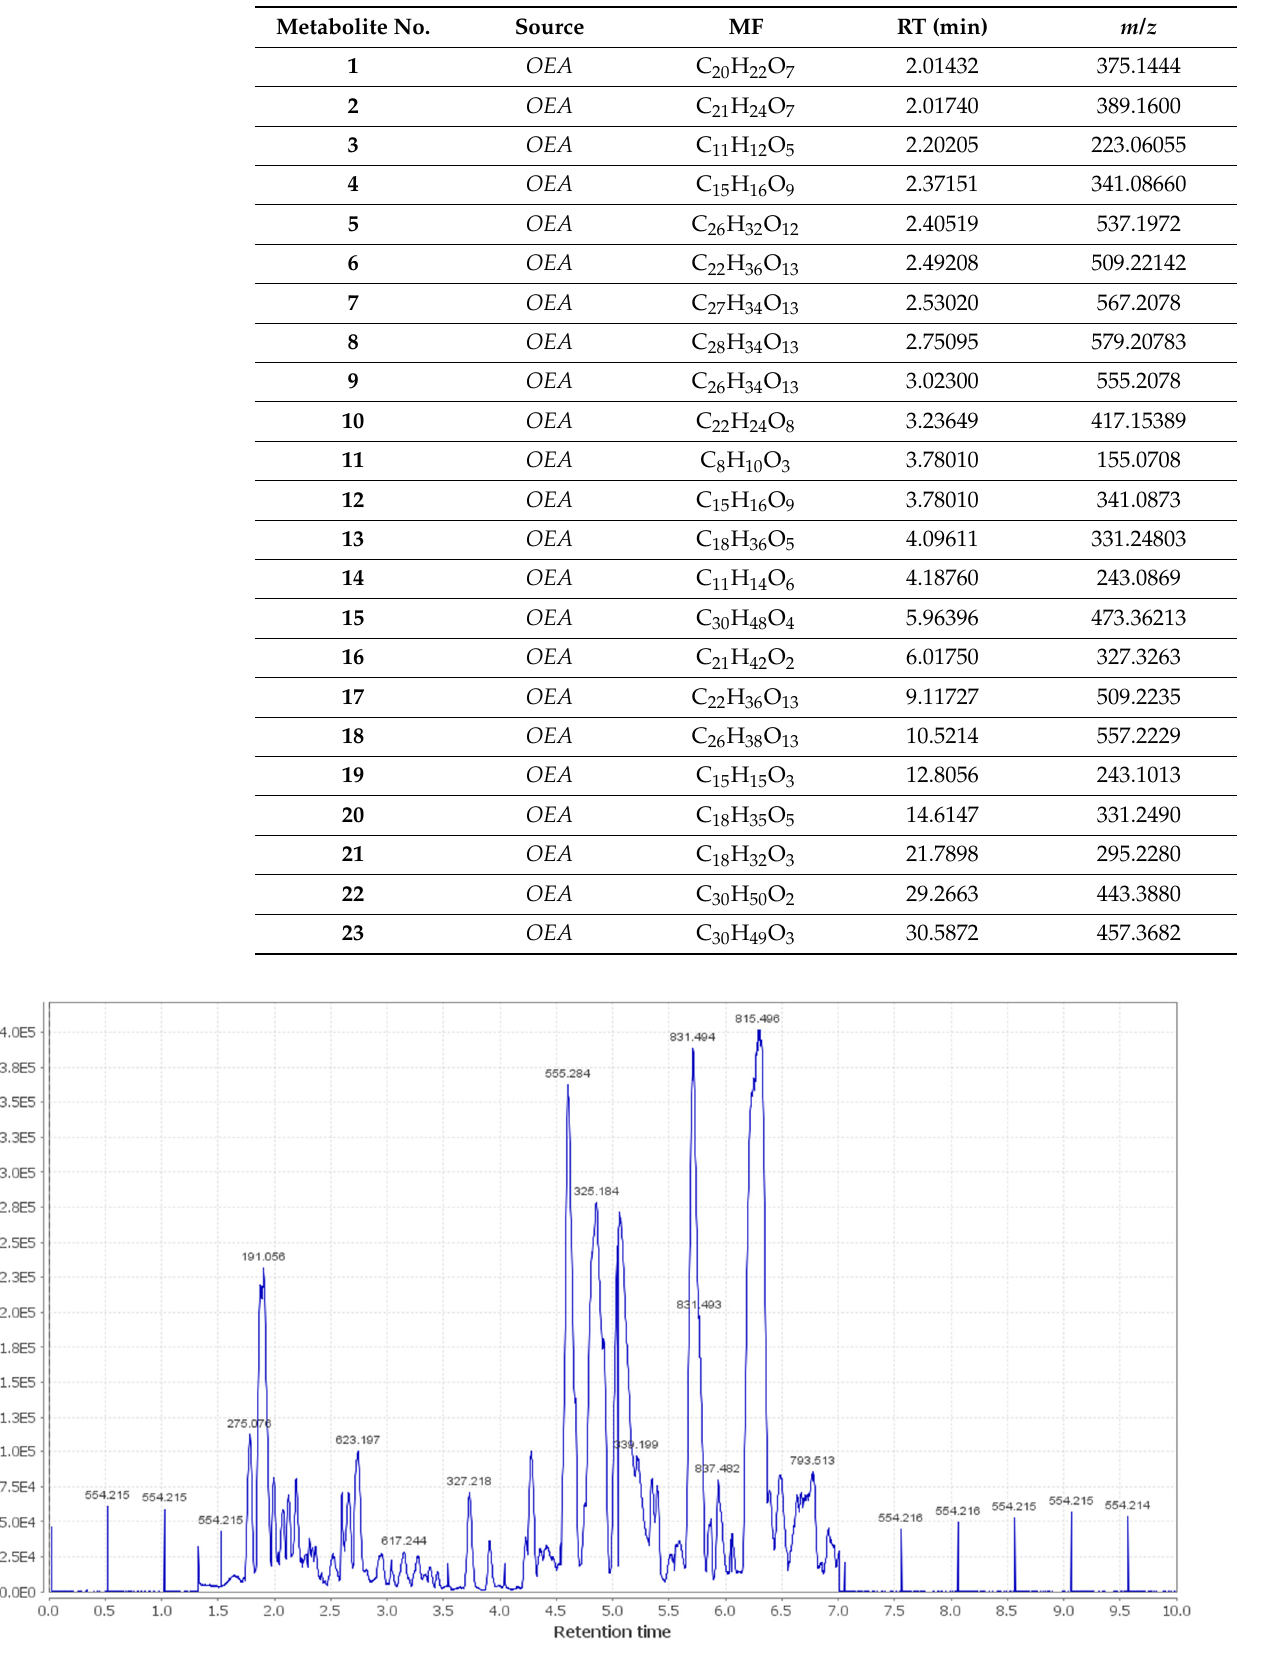
Figure 2. LC-HRESIMS chromatogram of the dereplicated metabolites of OEA (positive mode).